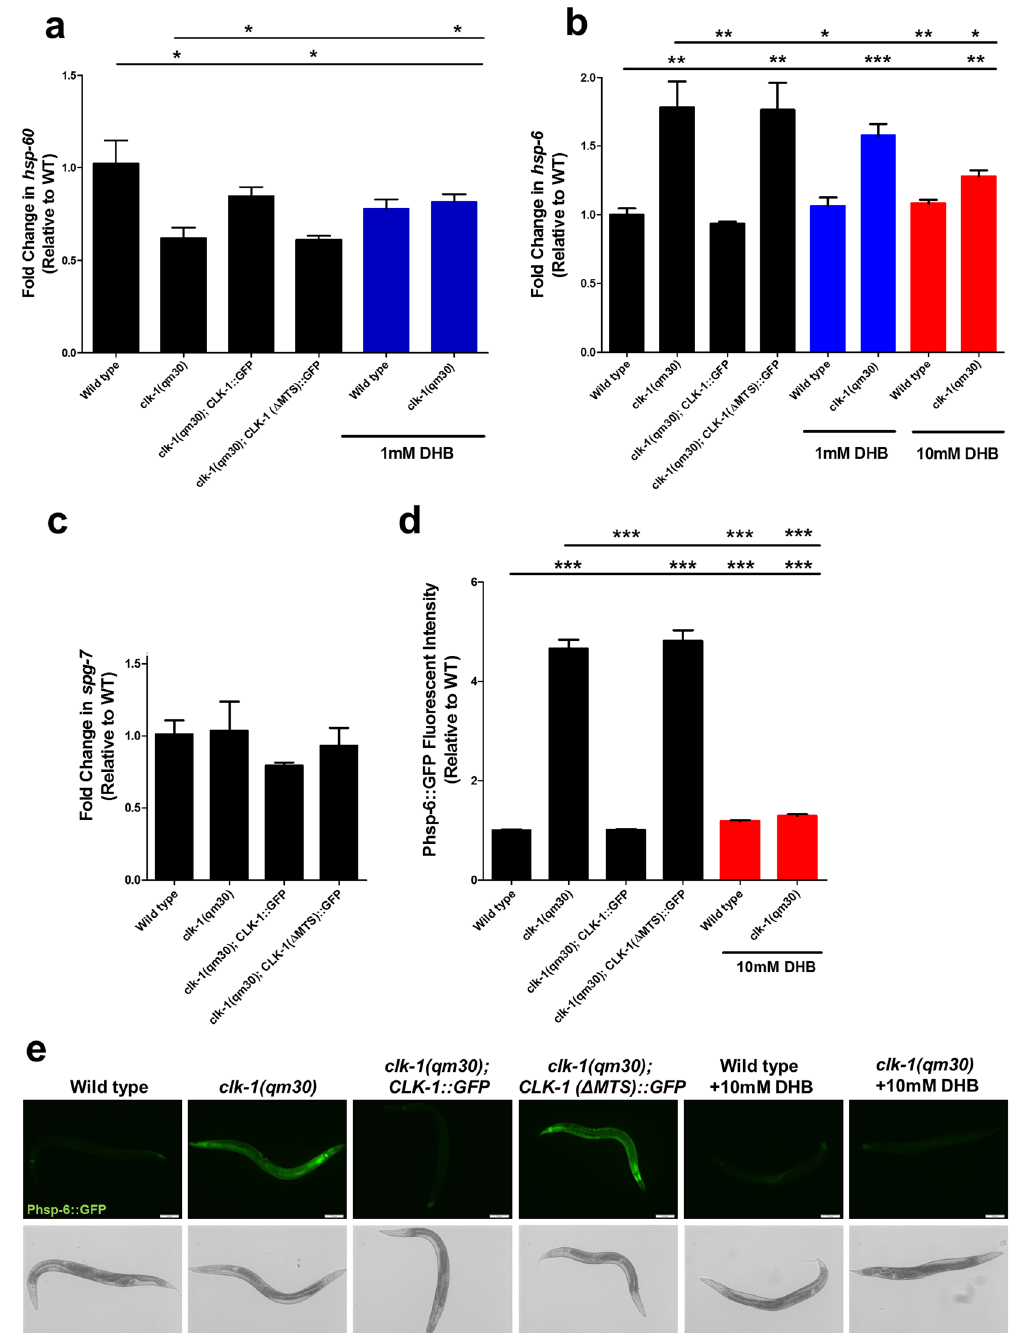
Figure 6. Changes in gene expression in clk-1 mutants can be rescued by the expression of CLK-1::GFP or by 2,4-DHB treatment. ( a , b ) The mRNA level of UPR mt genes was examined in day 1 adult worms by quantitative real-time PCR. Results were normalized to mRNA levels in wild type. clk-1 ( qm30 ) worms showed altered expressions of hsp-60 and hsp-6 . The expression of CLK-1::GFP, but not CLK-1( Δ MTS)::GFP, rescues the transcript levels of hsp-60 and hsp-6 in clk-1 mutants. The same rescuing effect can be achieved by treating clk-1 mutants with 2,4-DHB. ( c ) The spg-7 mRNA levels were the same for the all genotypes that we examined. ( d , e ) Quantification of GFP intensity from Phsp-6 :: GFP . Values are expressed as fold change in GFP fluorescence intensities relative to the GFP fluorescence intensity of the Phsp-6 :: GFP reporter in the wild type background. The treatment of 2,4-DHB decreased the reporter expression in clk-1 mutants, while it had only a small effect on the control strains. Error bars indicate S.E.M. (n ≥ 30 animals). * p < 0.05, ** p < 0.01, *** p < 0.001. Scale bar: 100 µ